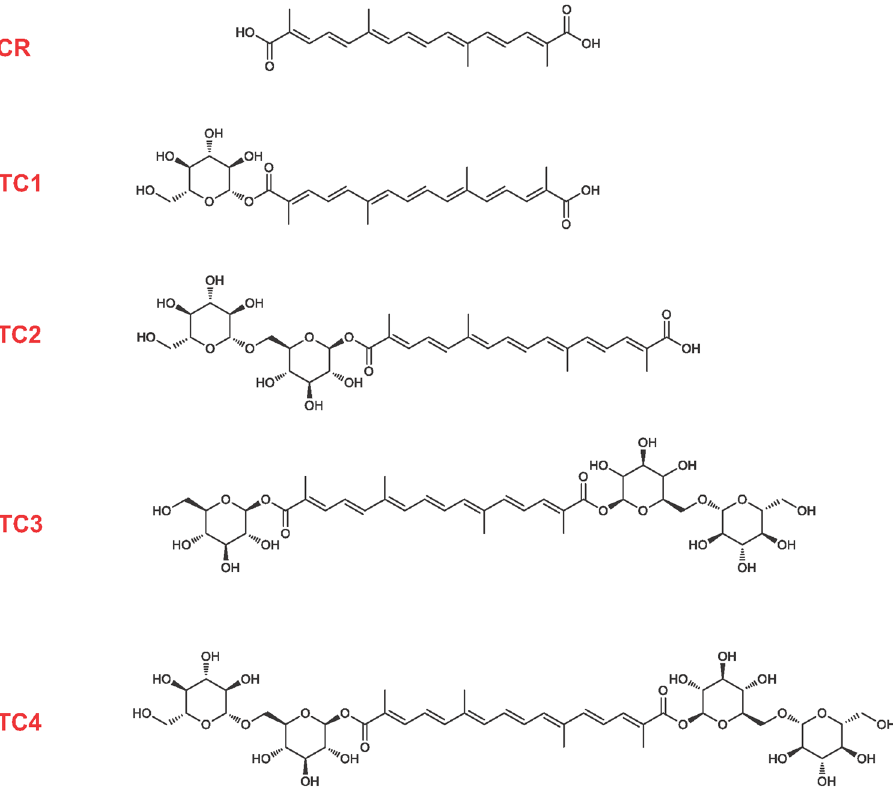
Figure 1. Chemical structures of selected crocin ester glycosides isolated from the stigmas of Crocus sativus L. The crocins are divided according to the number and the position of the β-l-glucopyranosides attached to the central carotenoid unit (Crocetin- CR), comprising crocetin mono- and bis-ester glycoside compounds with the end-substituents being mono- (Glycosyl- TC1) and bi- (1β-d-gentiobiosyl- TC2, TC3 and TC4) disaccharide